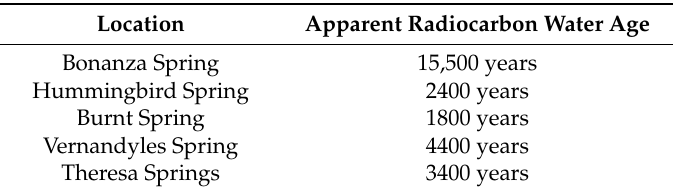
Table 3. Apparent water age for each of the sampled